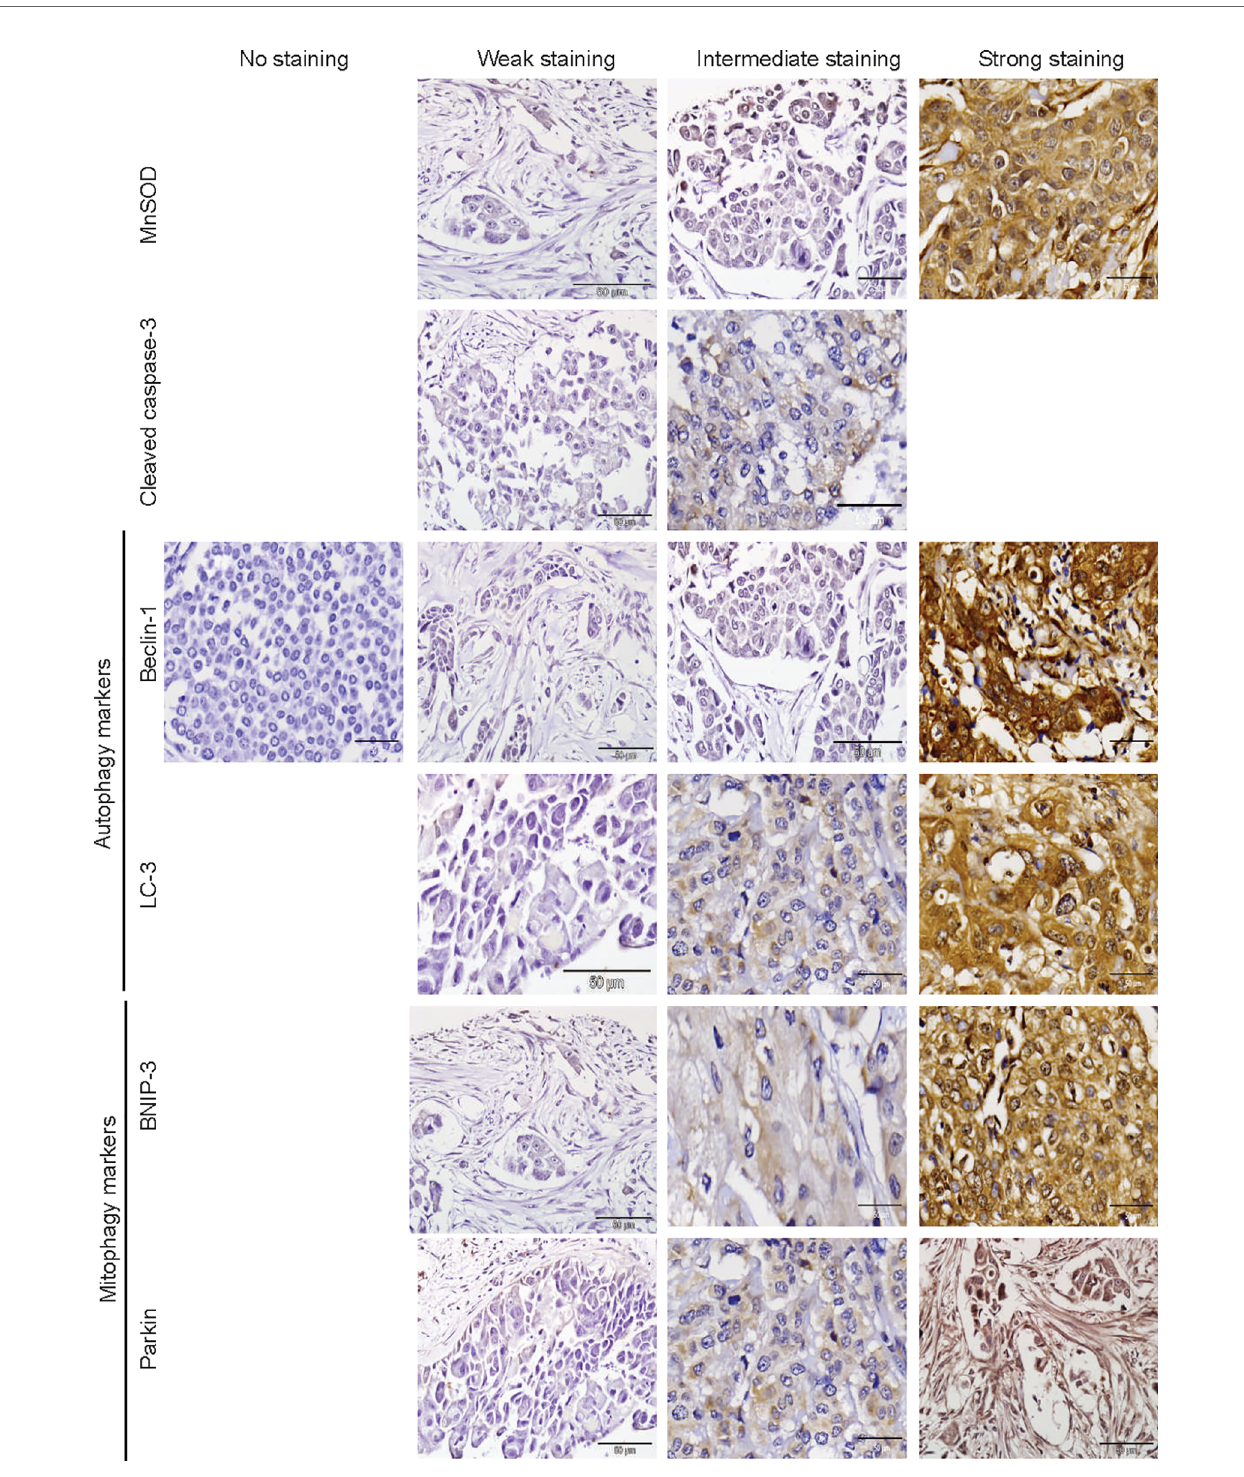
FIGURE 3 | Immunohistochemical staining of MnSOD, cleaved caspase-3, Beclin-1, LC-3, BNIP-3, and Parkin in breast tumor tissues. Representative images of MnSOD, cleaved caspase-3, Beclin-1, LC-3, BNIP-3, and Parkin staining (scored no, weak, intermediate, and strong staining) of tumor tissues obtained from breast cancer patient samples ( n =